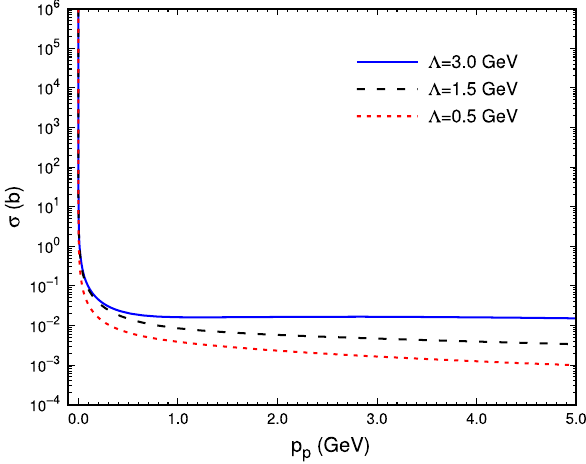
Fig. 2 Cross section of the p + T + cc → p + D + + D 0 reaction as a function of momentum of incoming proton p p = | p p | . The results with cutoffs (cid:21) = 3, 1.5, and 0.5 GeV are given as full (blue), dashed (black), and dotted (red)